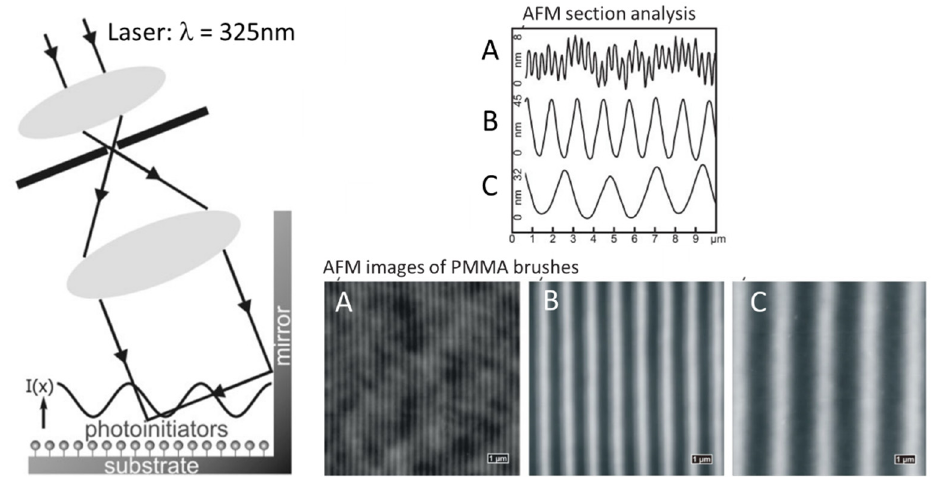
Figure 4. Setup for UV interference lithography and resulting polymer (PMMA) gratings (taken from reference [28]).